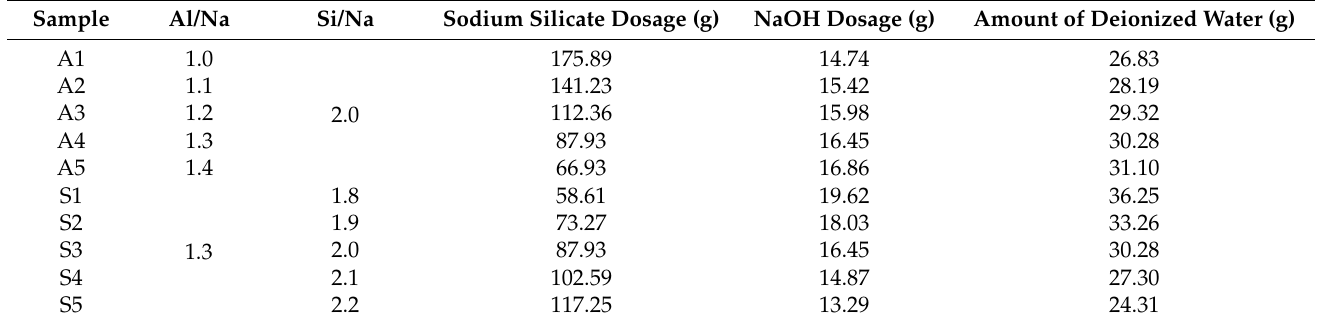
Table 2. The mix ratios of the metakaolin-based geopolymers that were tested in this